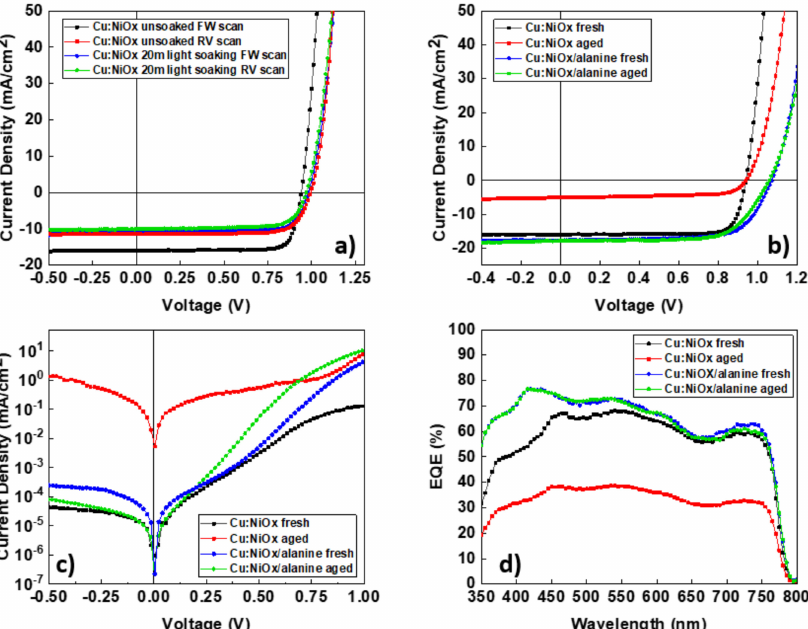
Figure 4. ( a ) Illuminated J / V characteristics of Cu:NiOx devices before and after light soaking, ( b ) illuminated J / V characteristics of fresh and aged Cu:NiOx and β -alanine-treated Cu:NiOx devices, ( c ) dark J / V characteristics of fresh and aged Cu:NiOx and β -alanine-treated Cu:NiOx devices, ( d ) EQE spectra of fresh and aged Cu:NiOx and β -alanine-treated Cu:NiOx